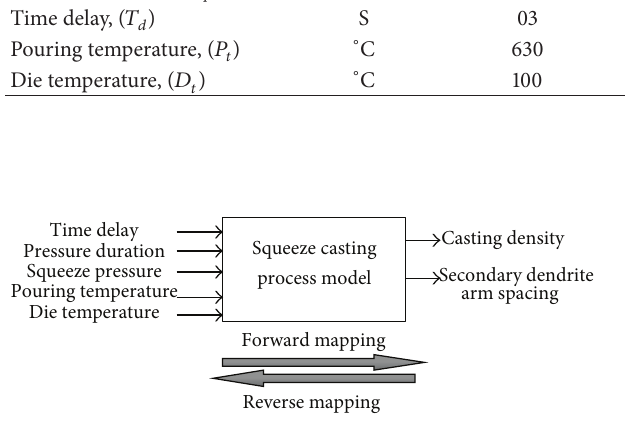
Figure 1: Forward and reverse squeeze casting process